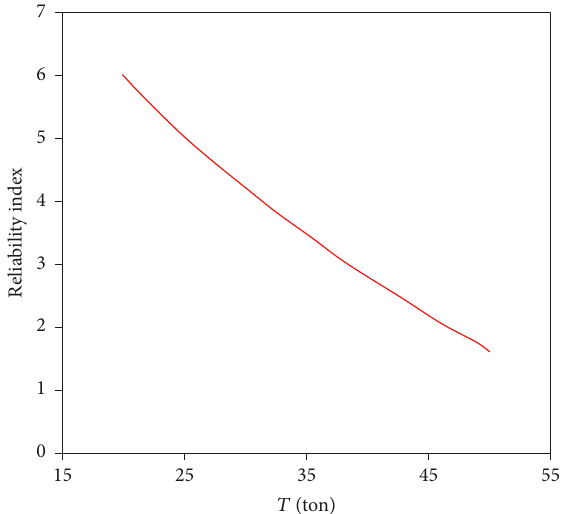
Figure 15: Minimum reliability index of the four failure modes of connection with respect to